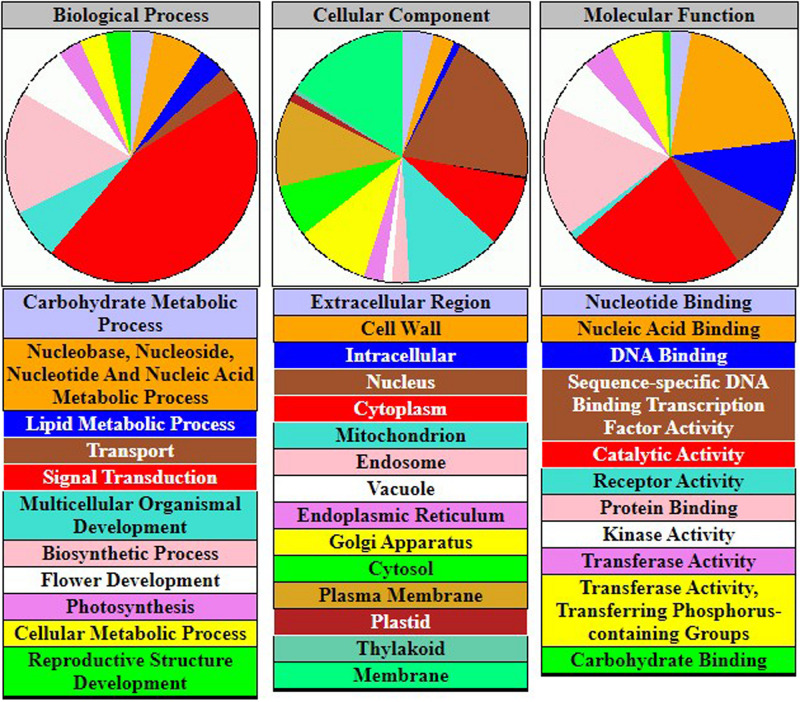
The gene-set enrichment analysis of 83 FTgenes.